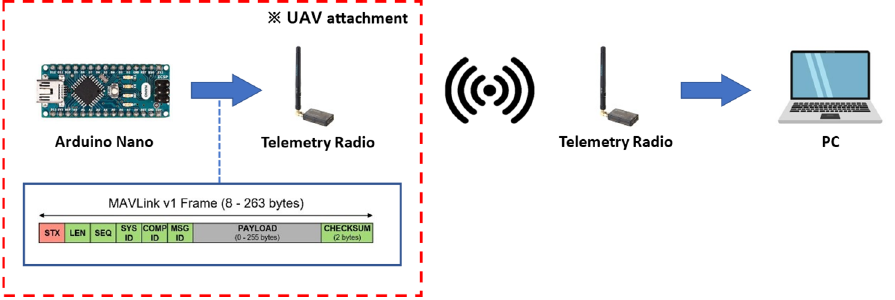
Figure 10. A configuration diagram of the long-distance wireless communication latency experiment.